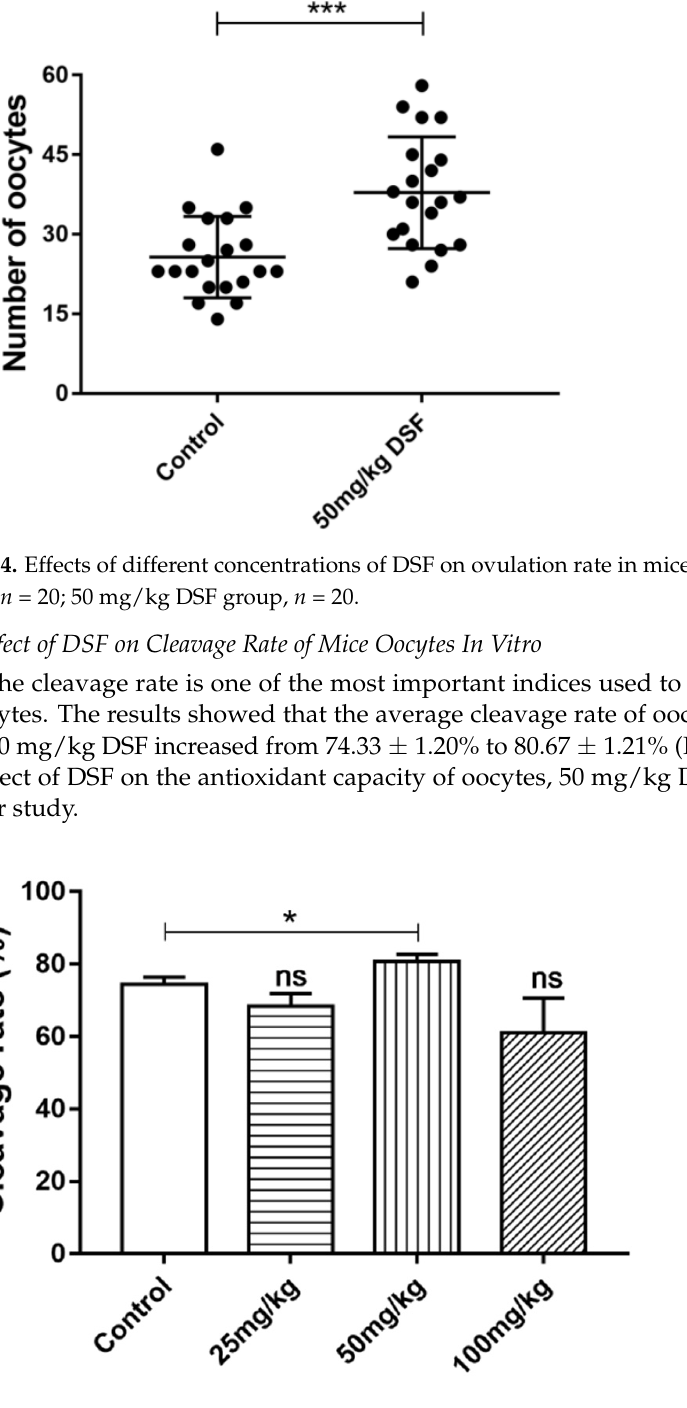
Figure 5. Effects of different concentrations of DSF on cleavage rate of mice oocytes in Vitro. * p < 0.05, ns p > 0.05. Each group tested more than 100 MII oocytes. 2.7. Effect of DSF on ROS Level in Mice Oocytes During the process of in vitro fertilization, oxidative stress is an important factor af ‐ fecting the development of oocytes [21]; indeed, excessive reactive oxygen species (ROS) inhibit the development of oocytes. The results showed that the level of ROS in mice MII stage oocytes decreased after DSF treatment (Figure 6).